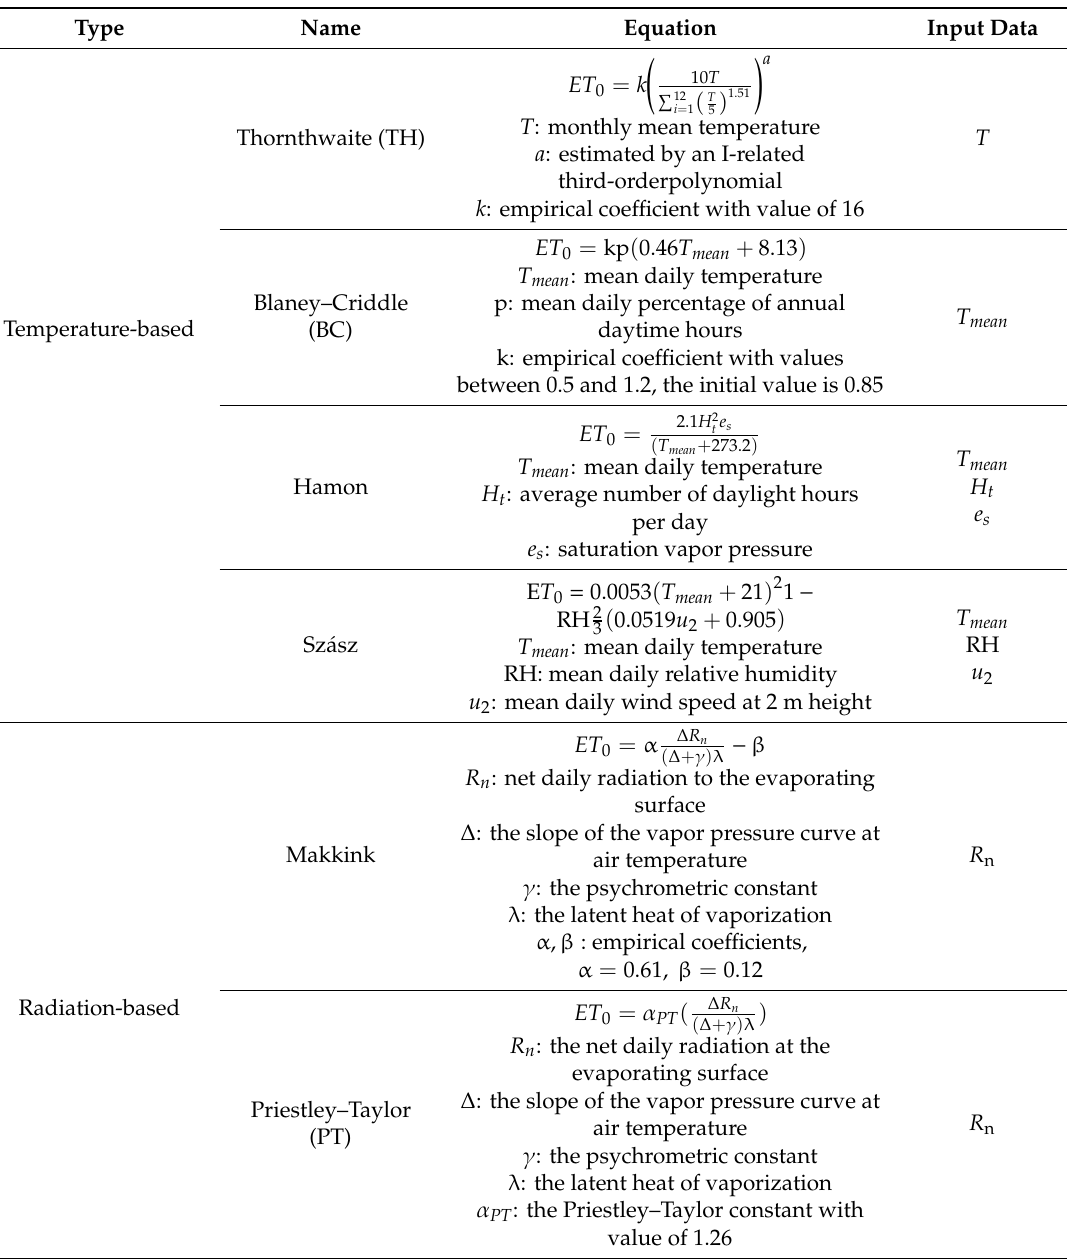
Table 3. Summary of evapotranspiration models applied in the